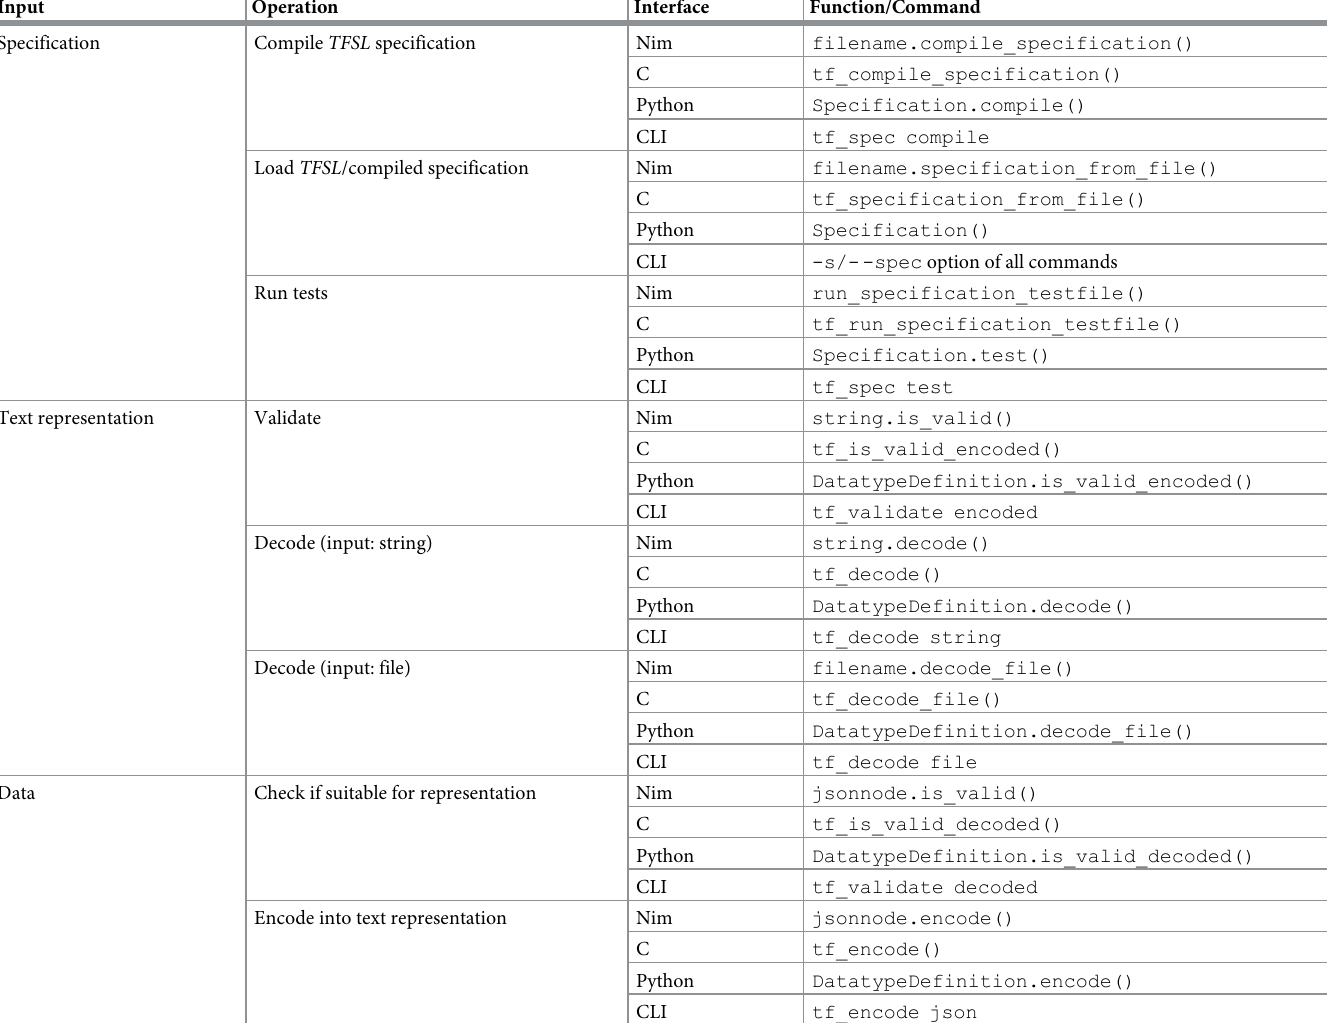
Table 3. Operations implemented by TextFormats and corresponding API functions and CLI